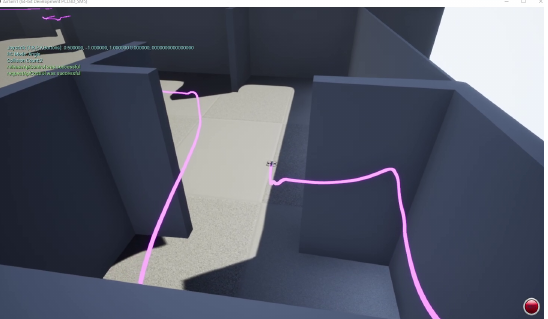
Figure 6. A 3D screenshot of the simulation. The magenta line represents the path of the simu- lated